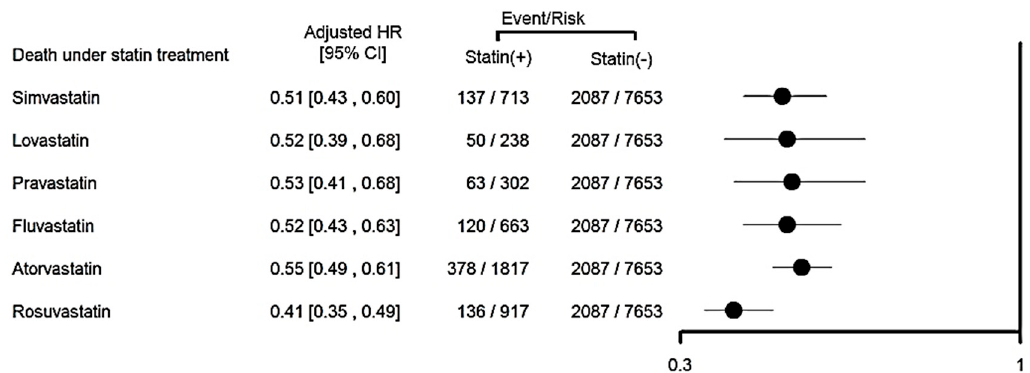
Figure 3. The adjusted hazard ratio for statin users versus non-users in advanced chronic kidney disease patients on the incidence of all-cause mortality with post-propensity score matching, stratified according to individual statin therapy. HR, harzard ratio.